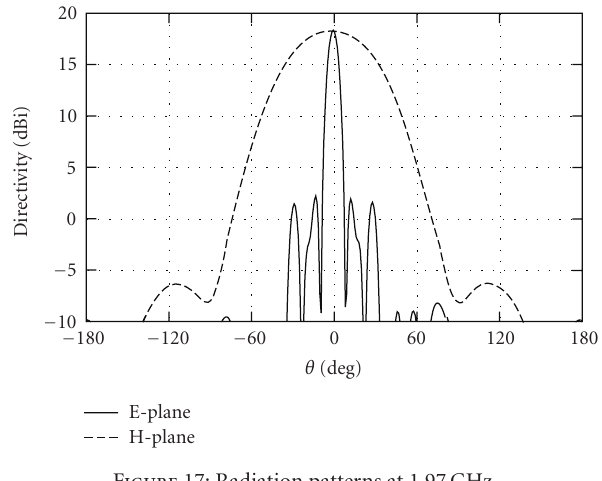
Figure 17: Radiation patterns at 1.97 GHz.